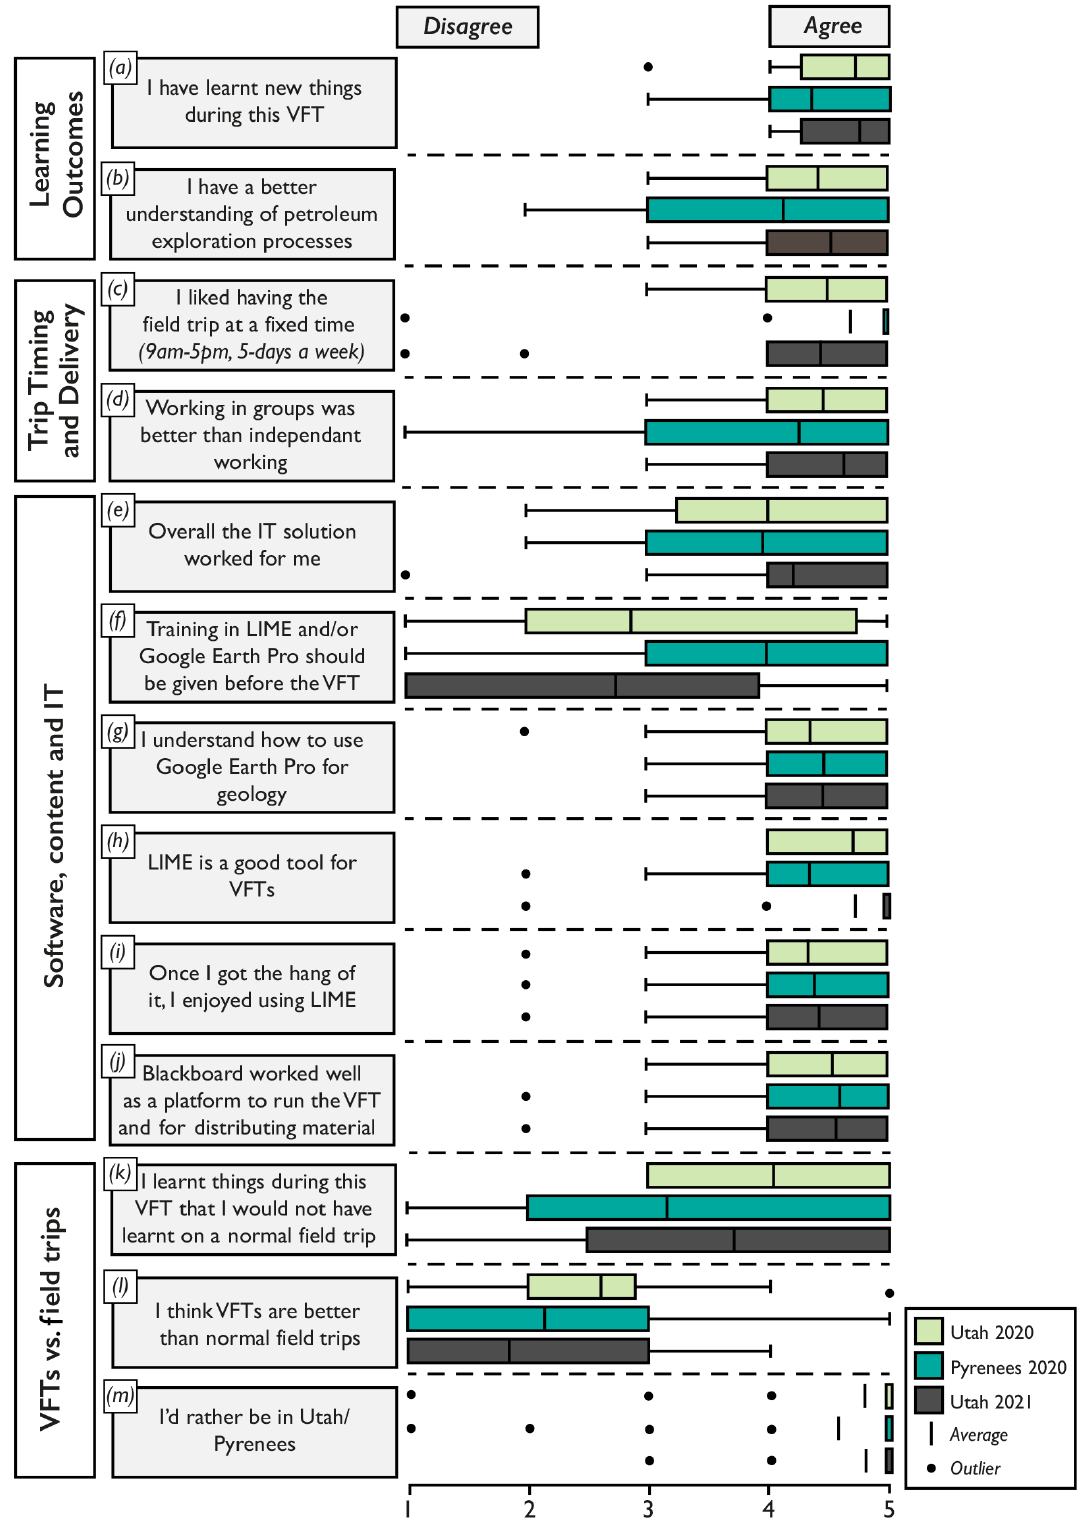
Figure 8. Quantitative responses to questionnaires for all three VFTs presented as box-and-whisker plots. Panels (a) and (b) summarize learning outcomes; panels (e) to (j) summarize software, content and IT; and panels (k) to (m) summarize comparative statements between VFTs and traditional field trips. Responses are collated for each trip presented for